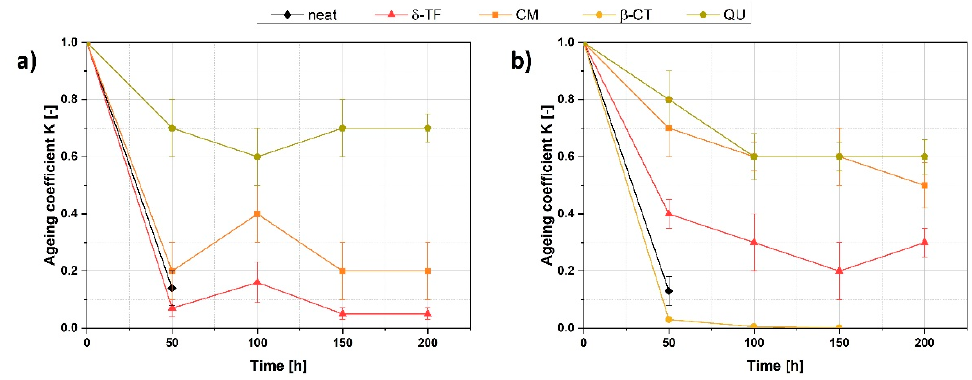
Figure 6. Color change representation for the prepared ENR/PLA blends before and after the ac- celerated thermo-oxidative (T), as well as UV-initiated (UV) aging processes. *—sample destroyed significantly.